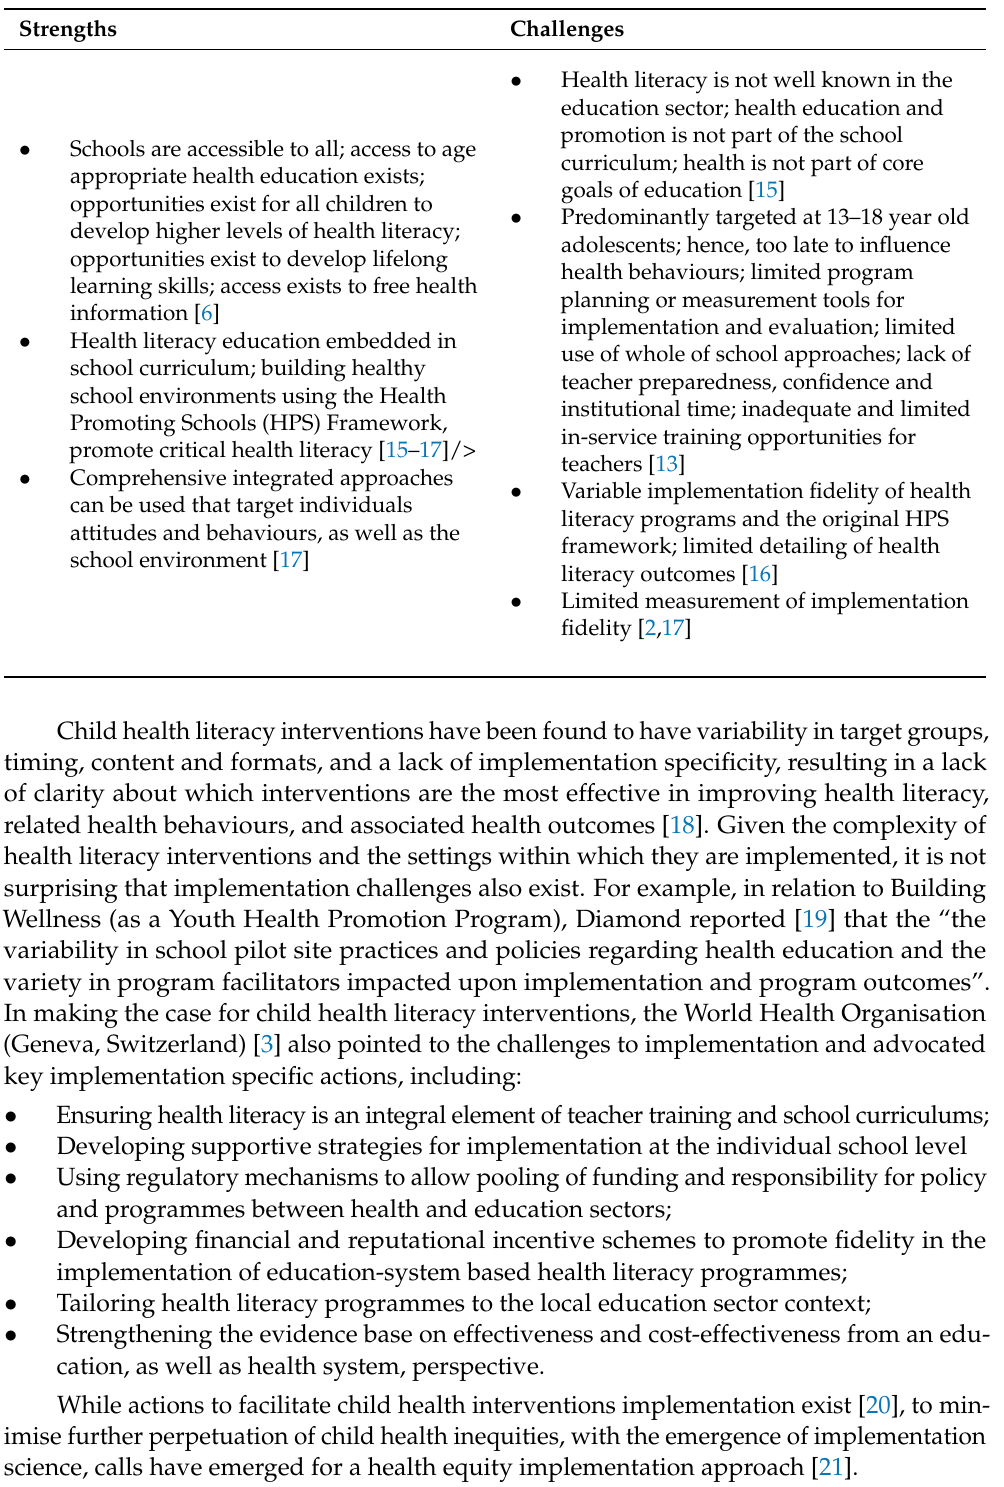
Table 1. Strengths and Challenges of School-based Child Health Literacy interventions.